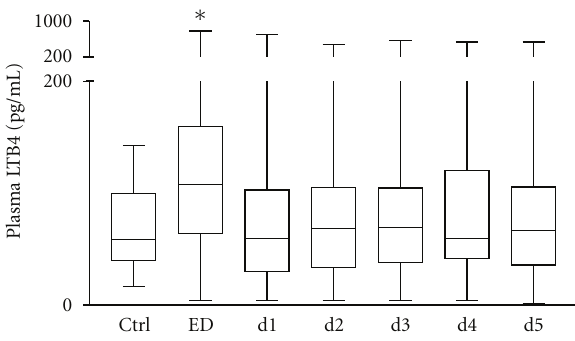
Figure 1: Summary of median (interquartile range) LTB4 (pg/mL) in multiply traumatized patients over a 5-day time course after admission ( n = 100), and ctrl ( n = 20). ∗ P < 0 . 05 versus other